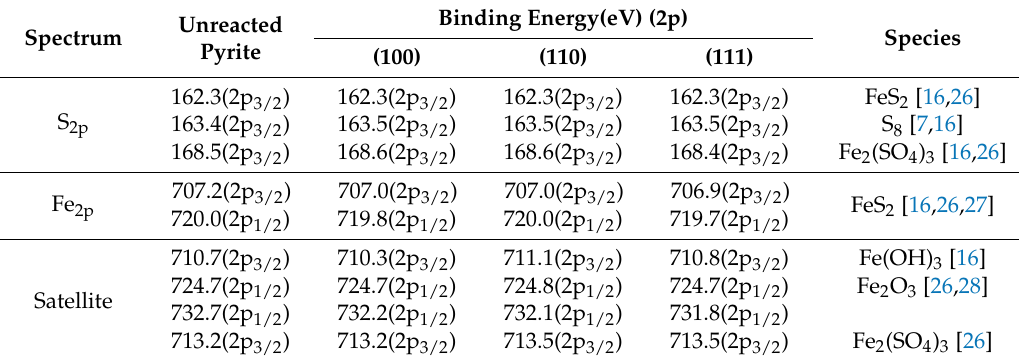
Figure 8. XPS spectra of pyrite (100), (110) and (111) after oxidation for eight days: S(2p) ( a ) and Fe(2p) ( b ). Table 2. Binding energy of Fe(2p) and S(2p) after oxidation for eight